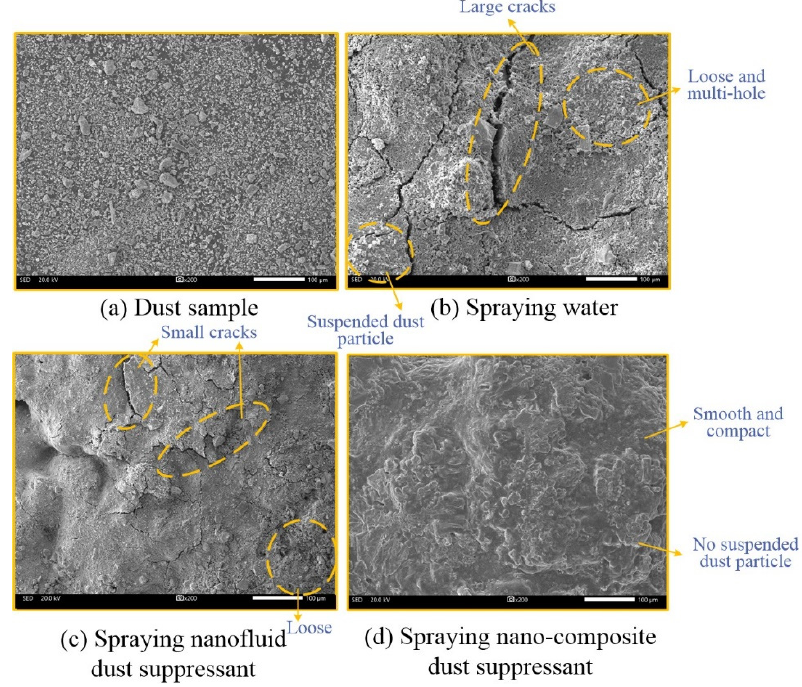
Figure 8. Photos of SEM.